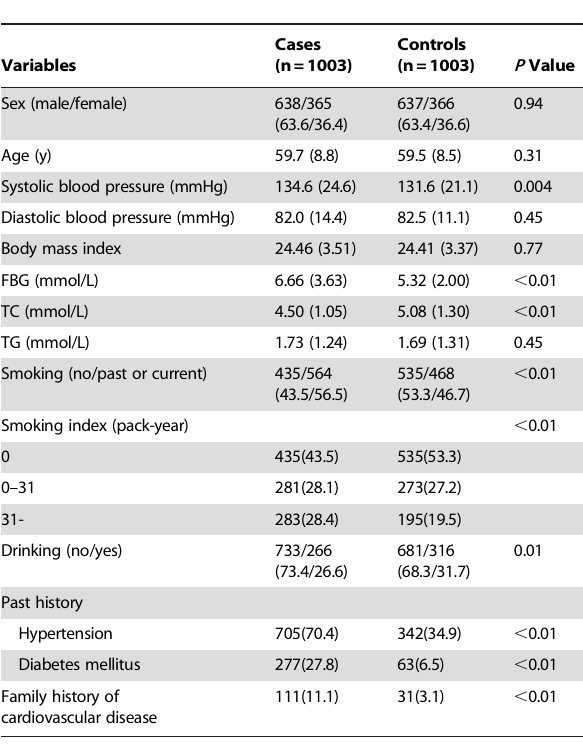
Table 2. General characteristics of CHD cases and controls *